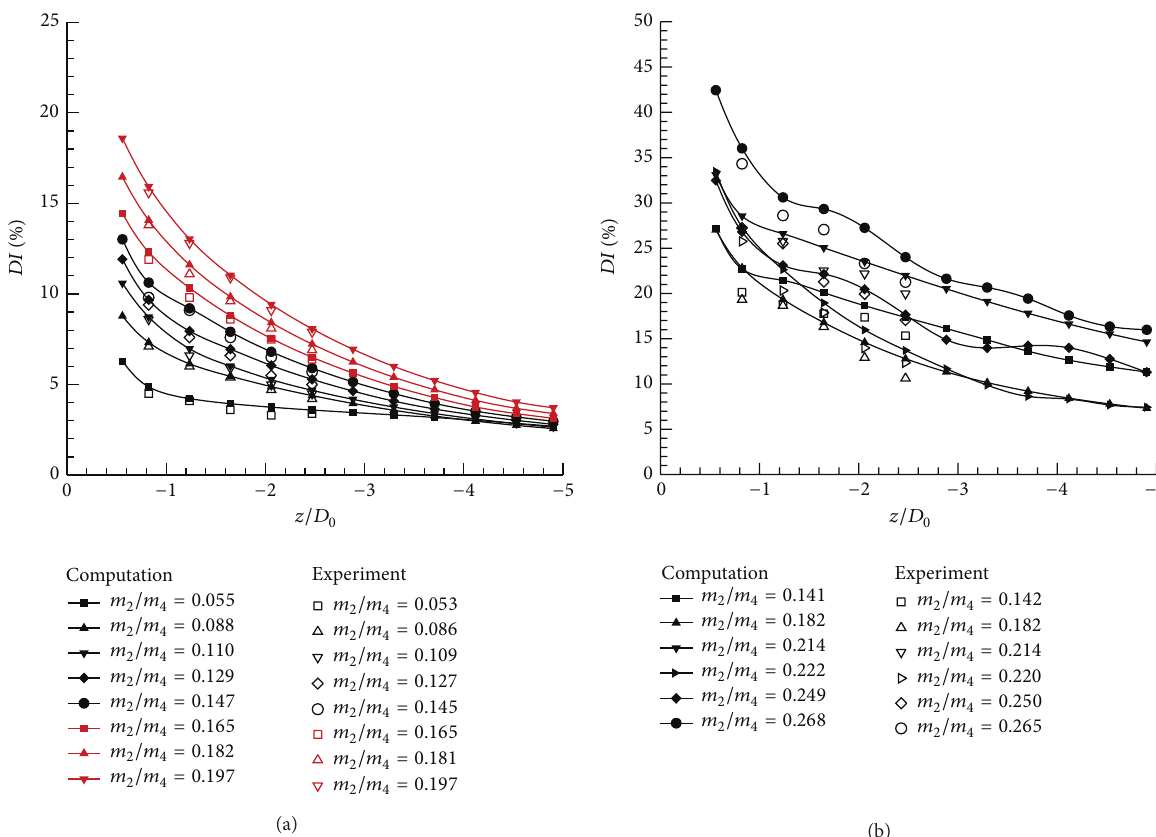
Figure 5: Distortion index ( DI ) at several locations behind the jet injectors plotted for different values of 𝑚 2 /𝑚 4 . (a) Four jets with equal mass flow rates and (b) four jets with unequal mass flow